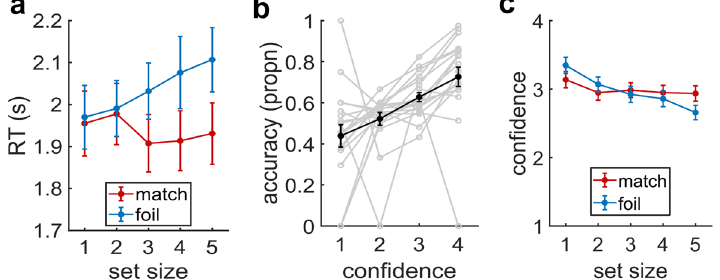
Figure 5. Response times and confidences in Experiment 2. ( a ) Response times (in seconds) for match and foil trials across the set size. ( b ) Recognition accuracy (in proportion correct) for each confidence level (1 = not confident, 4 = very confidence). ( c ) Confidence for match and foil trials across the set size. Data points are means; error bars are SEM. Gray lines represent single-subject data (N = 20).